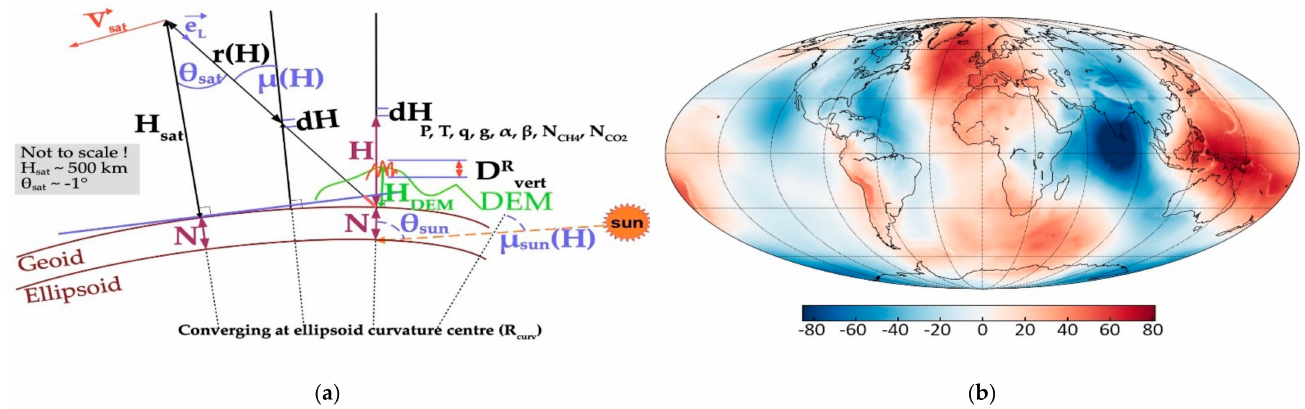
Figure 9. ( a ) Observation geometry (for the notations see the text). ( b ) Global map of geoid height provided by EGM08 (in